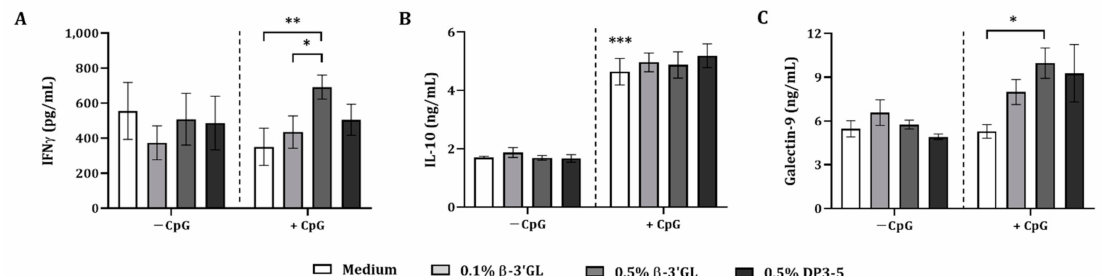
Figure 5. Cytokine and galectin-9 secretion by β -3 (cid:48) GL and CpG in the IEC/PBMC co-culture model. IEC were apically exposed to β -3 (cid:48) GL (0.1% and 0.5% w / v ) or GOS DP3-5 (0.5% w / v ) in combination with 0.1 µ M CpG and basolaterally to α CD3/CD28-activated PBMC. After 24 h of incubation, IFN γ ( A ), IL-10 ( B ), and galectin-9 ( C ) were measured in the basolateral supernatant. The data shown are represented as mean ± SEM of n = 6 independent PBMC donors (except for IFN γ n = 5) (* p < 0.05. ** p < 0.01, *** p <